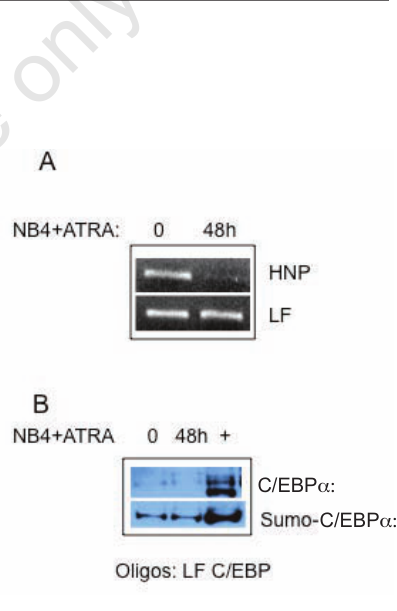
Figure 4. Binding of Sumoylated-C/EBPA to the LF C/EBP a oligomers in ATRA- induced NB4 leukemic cells: A. Chromatin immunoprecipitation was per- formed from uninduced (0) and ATRA- induced (48h) NB4 cells using antibodies specific for C/EBP a . The precipitated chromatin was analyzed using primers specific for the human LF (LF) promoter (bottom panel) and the HNP promoter (top panel). This experiment was repeated three times. B. Oligonucleotide pulldown assay of C/EBP a and sumoylated-C/EBP a during ATRA-induction of NB4 cells. Nuclear extracts prepared from uninduced (0) and 48h ATRA-induced NB4 cells were incubated with biotinylated C/EBP site (LF/C/EBP) oligomers from the LF pro- moter and oligonucleotide pulldown assay conducted as above. The blot was probed sequentially with anti-C/EBP a (top panel) and anti-SUMO-1 (bottom panel) anti- bodies. + represents a positive control (uninduced MPRO